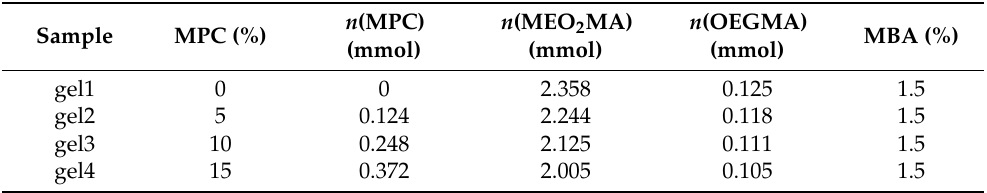
Table 1. Synthesis data of hydrogels.